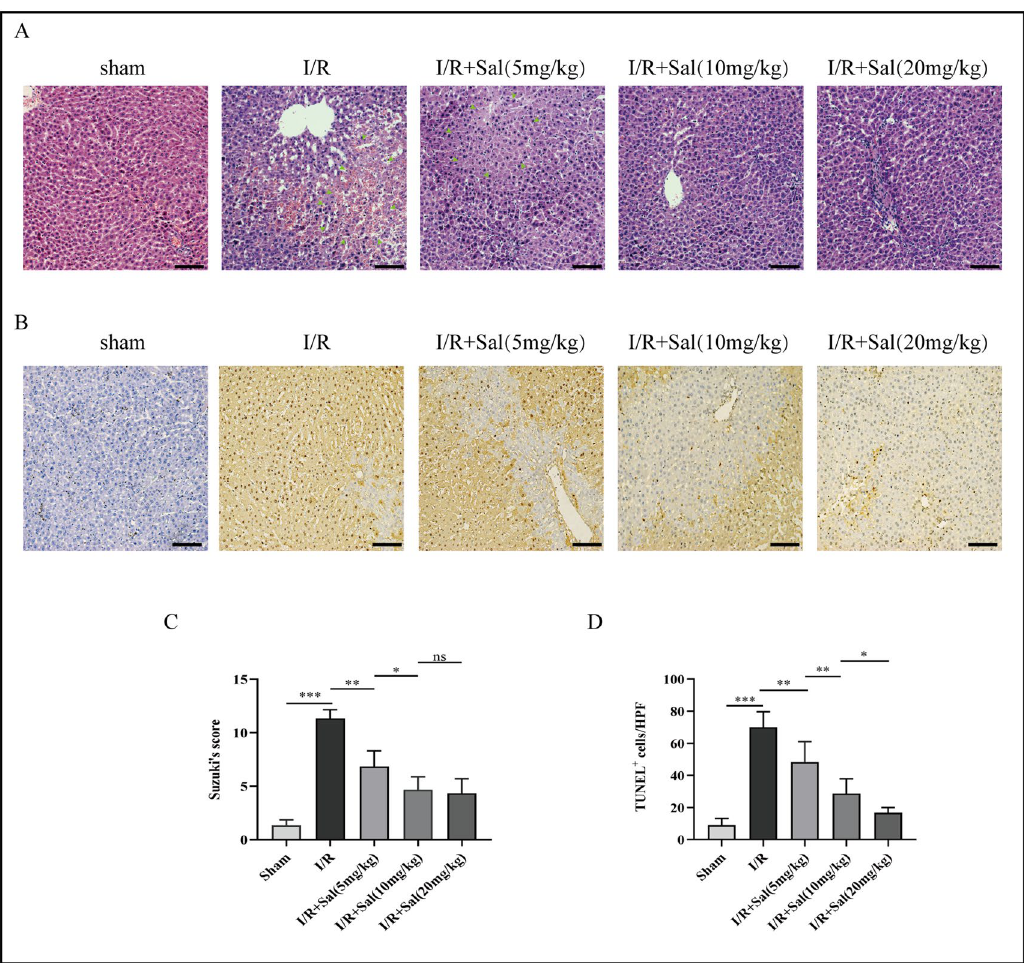
Figure 2. Salidroside attenuates hepatic histopathological changes and hepatocyte apoptosis of the rats following liver transplantation. ( A ) Representative HE staining images showing hepatic histological alterations (indicated with arrowheads) in the rat liver (magnification, 200; scale bar, 200 m; n = 6). ( B ) Hepatic apoptosis detected by TUNEL assay (magnification, × 200; scale bar, 200 μm; n = 6). ( C ) Hepatic IRI grading based on suzuki’s grade. ( D ) TUNEL + cells of the liver based on TUNEL assay. The statistical differences among groups were assessed by one-way ANOVA. ns P > 0.05, * P < 0.05, ** P < 0.01, *** P <